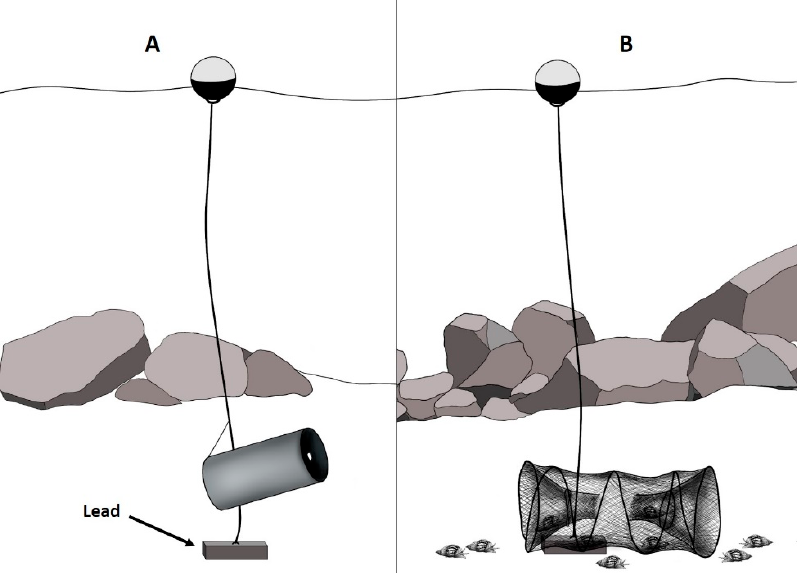
Figure 3. Deployment scheme of benthopelagic macrofauna ( A ) and Megafauna ( B ) baited traps.